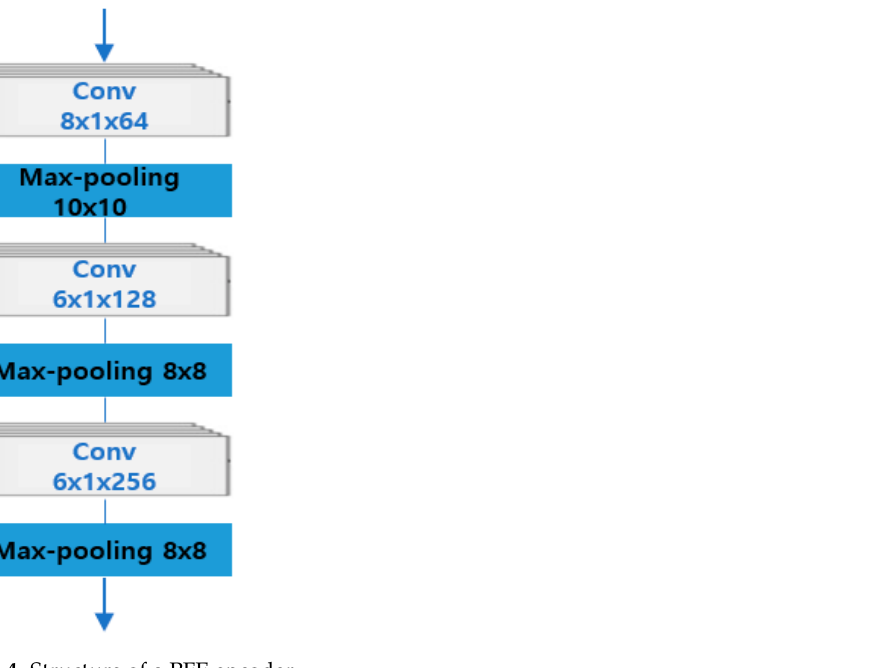
Figure 4. Structure of a PFE encoder.